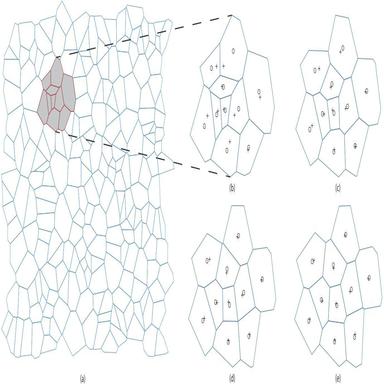
Example of the granular structure obtained via the centroidal Voronoi tessellation (a). A subsection has been chosen to illustrate Lloyd's relaxation algorithm after: zero (b), one (c), two (d) and three (e) iterations. The seed points are indicated by the crosses with the centroids represented by the circles. As more iterations are performed the angular nature of the grains is reduced.